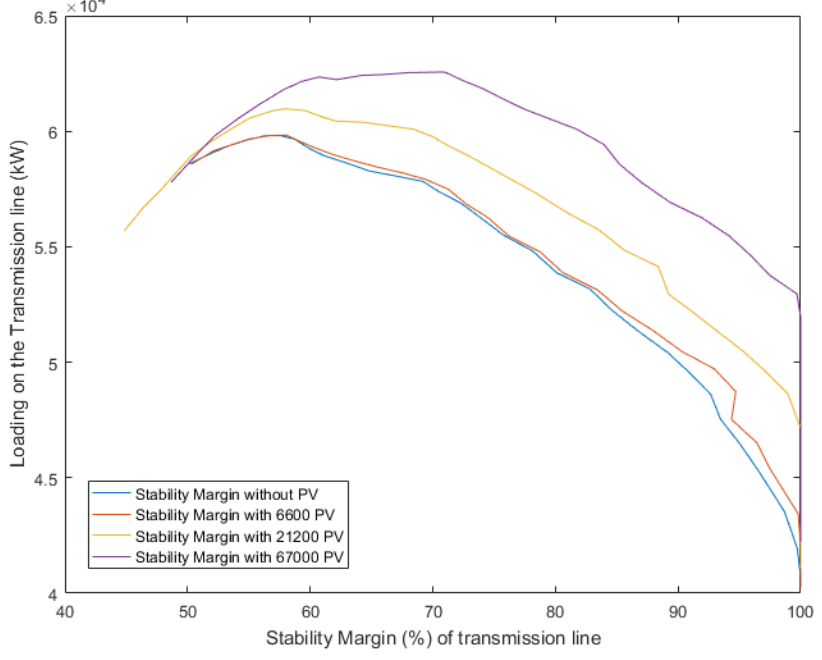
Figure 4. Loading vs. stability margin for selected line for various PV penetration levels.